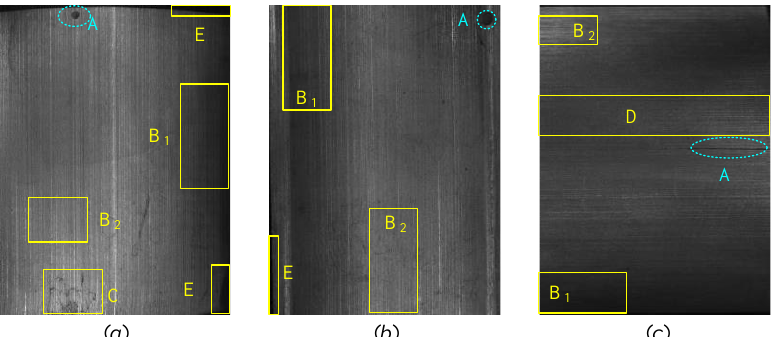
Figure 1. Examples of a magnetic tile surface defect dataset [6]: ( a , b ) blowhole; ( c ) crack. The proportion of a small defect is extremely low at the A region, and the brightness distribution of the background is pretty uneven between the B 1 and B 2 regions in ( a – c ); the contrast between the defect and the background is extremely low at the A region in ( b ); the color of the defect at the A region is extremely similar to the black background at the E region in ( a , b ); the color of the blowhole defect at the A region and the stains at the C region are highly similar in ( a ); the crack defect at the A region is similar to the texture structure at the D region in ( c